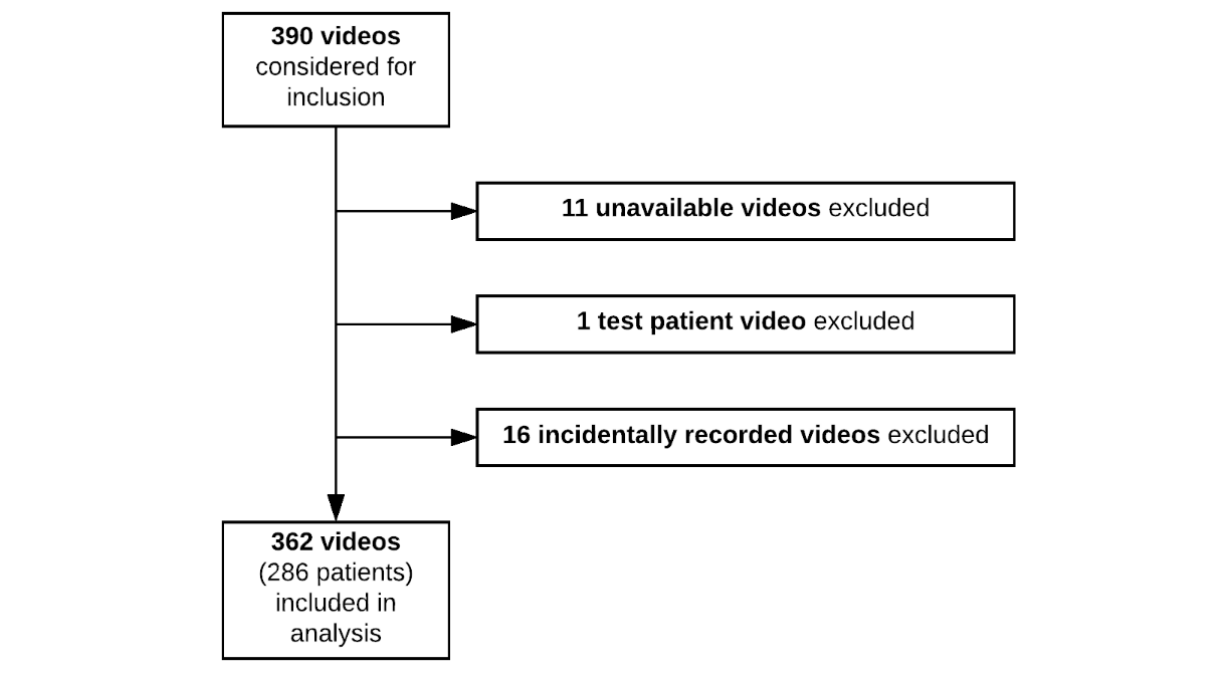
Figure 2. Patient record